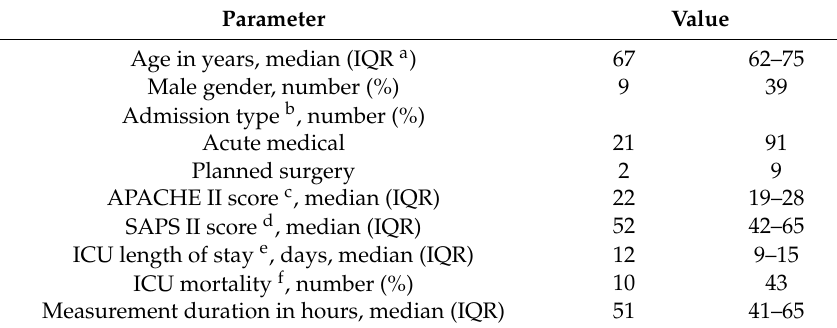
Table 1. Patient